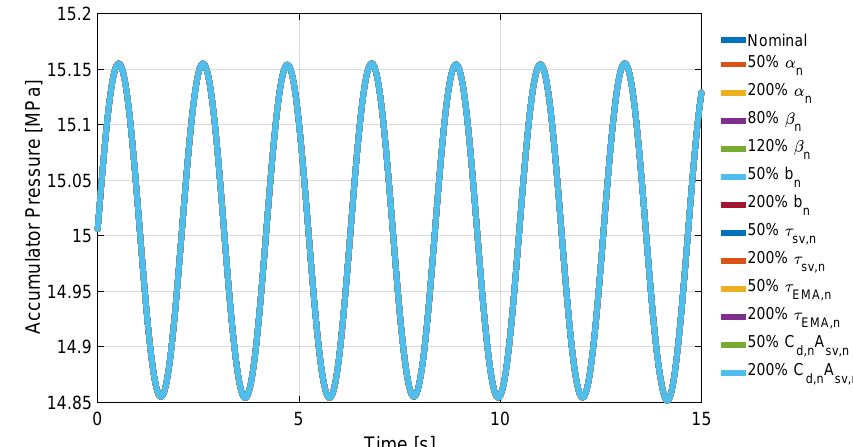
Figure 8. Simulation #1: Accumulator Pressure.